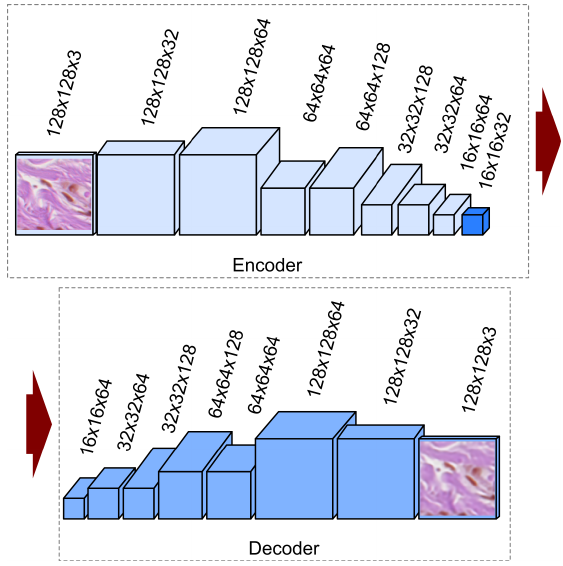
Figure 6. Architecture of the proposed convolutional autoencoder. Each box corresponds to a multichannel feature map. The horizontal arrow denotes transfer between the encoding and decoding